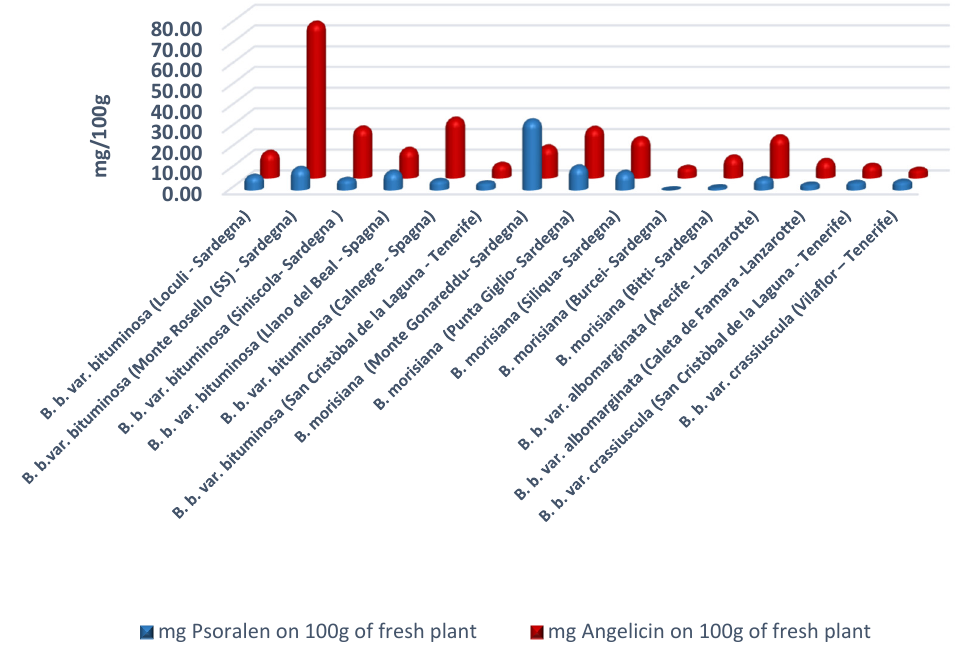
Figure 1. Content of psoralen and angelicin in the analyzed Bituminaria species and varieties (mg/100 g, fresh plant).